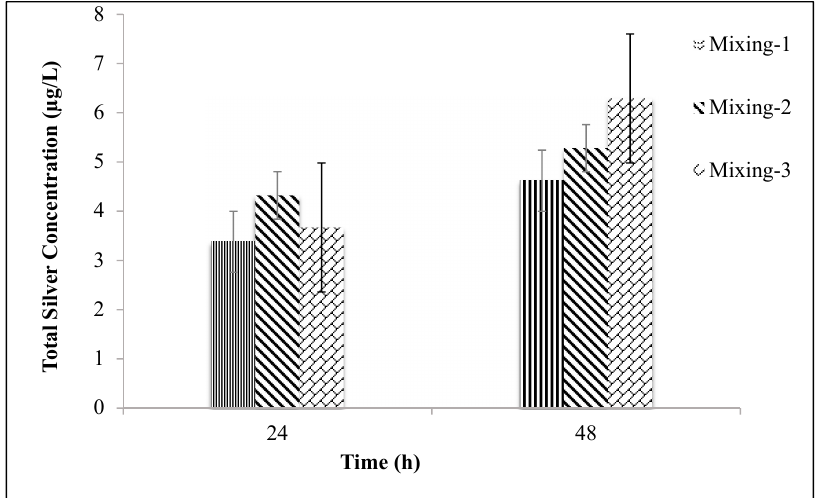
Figure 8. E ff ect of di ff erent mixing (of raw material) methods in the fabrication of ceramic tablets on the total silver release in 10 L of water at 0, 24, and 48 h using 20 mesh sawdust. Mixing 1: Sawdust +